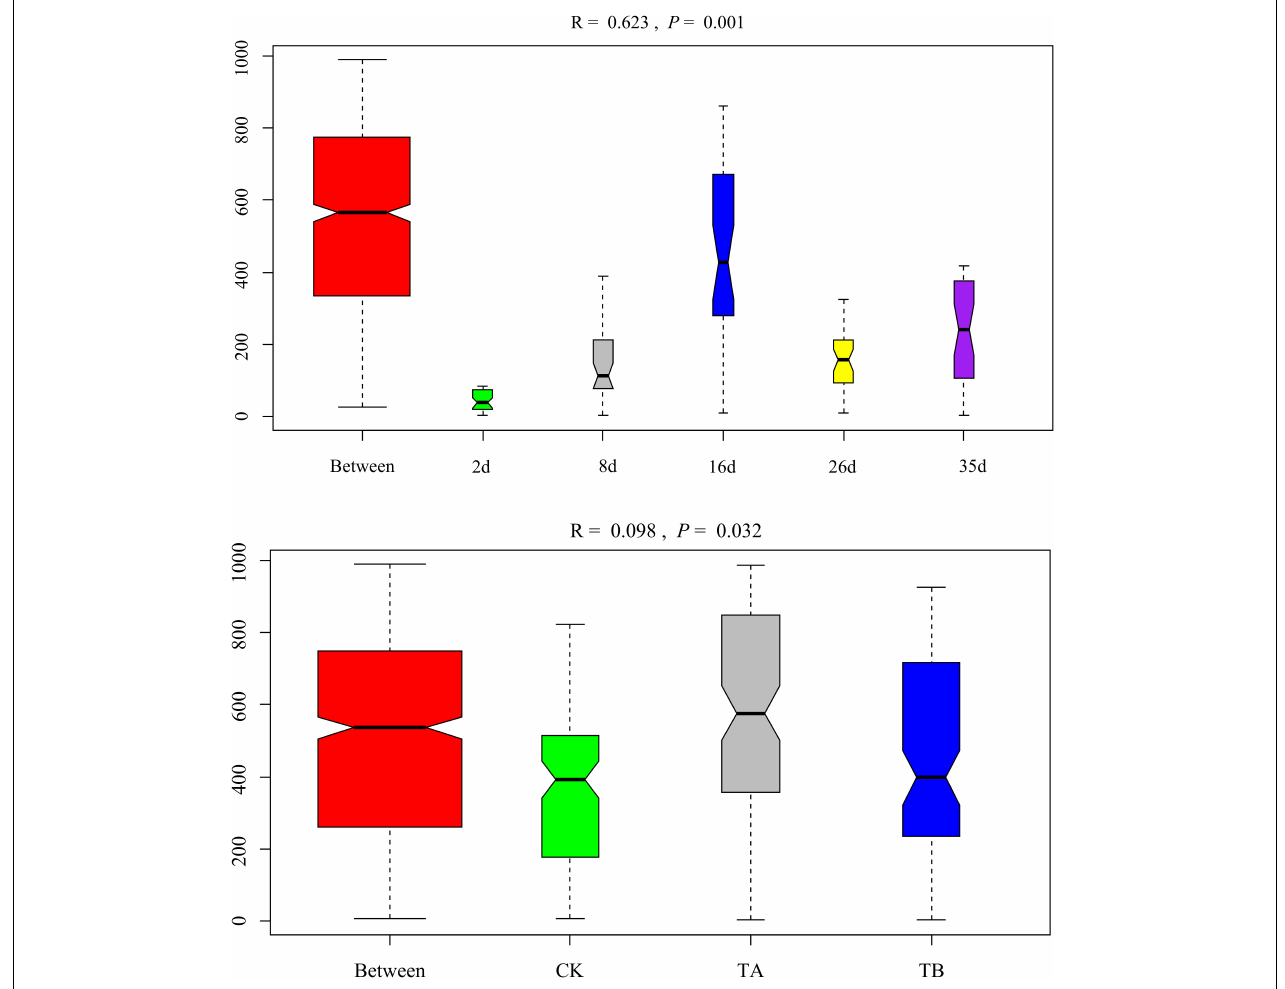
FIGURE 5 | Analysis of similarities (ANOSIM) plot of Bray–Curtis dissimilarity ranks between composting period and treatment for bacterial composition at the genus